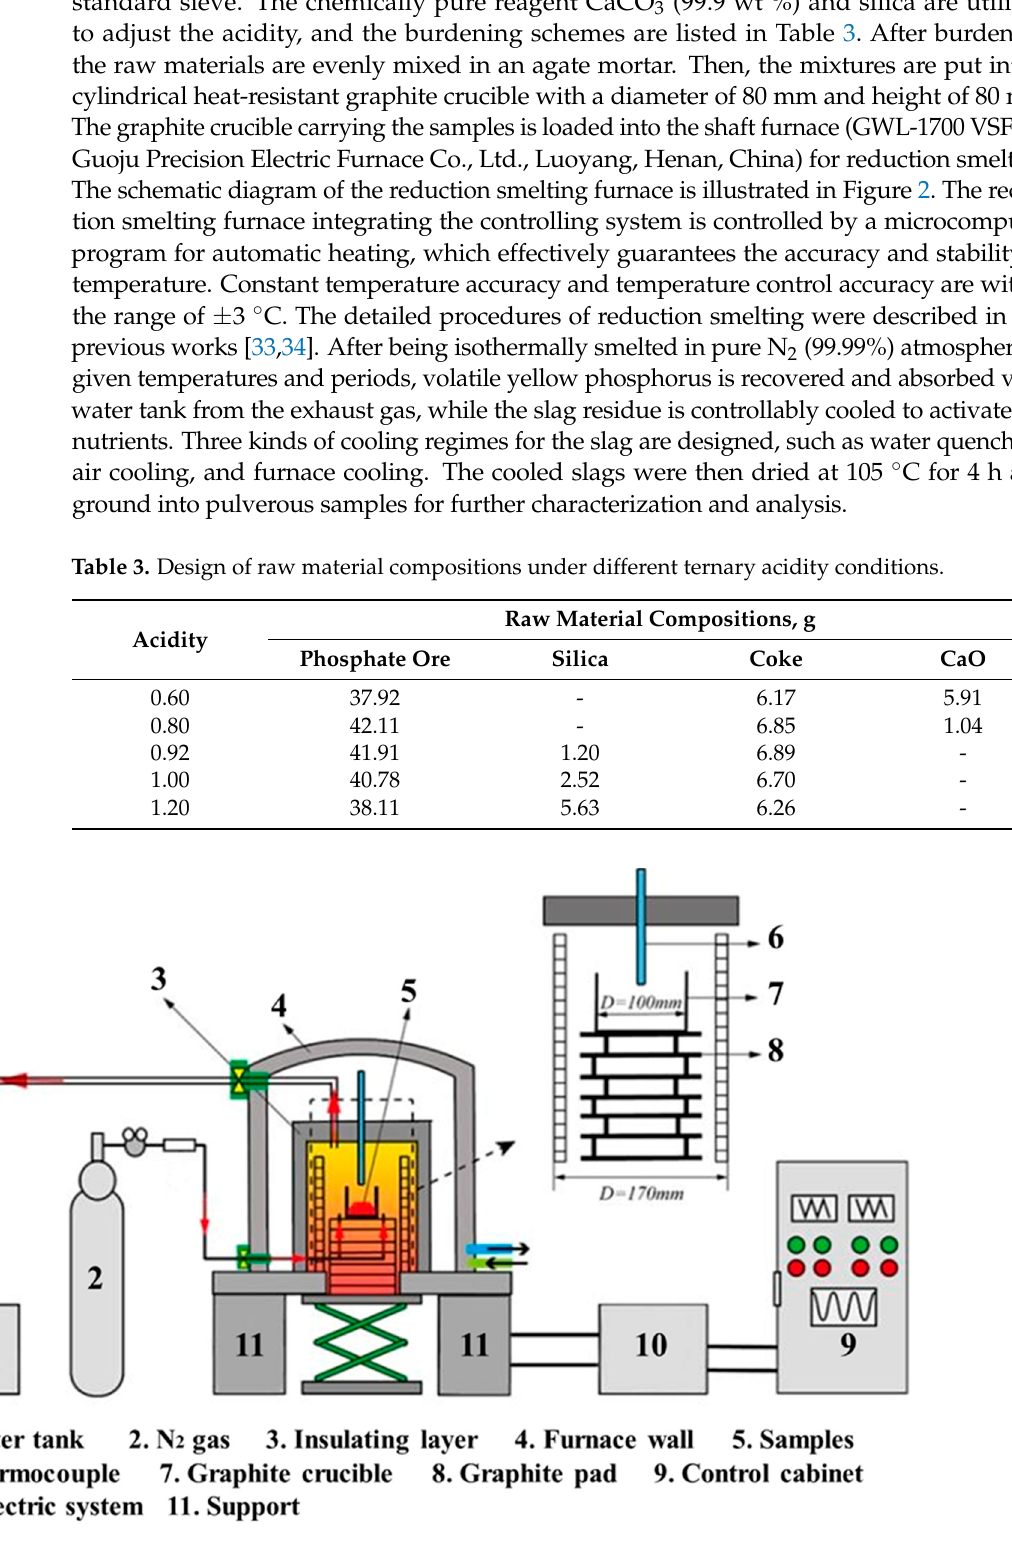
Figure 2. Schematic diagram of the reduction smelting furnace.